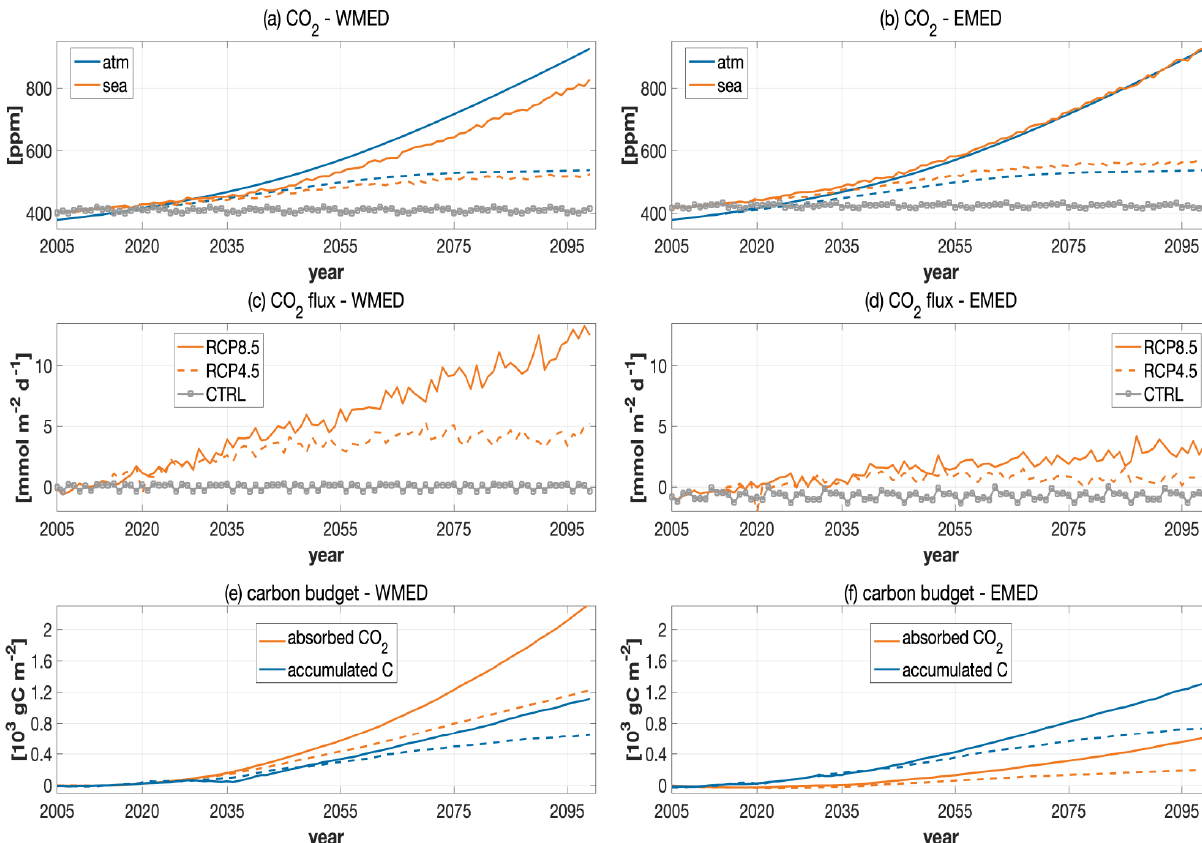
Figure 16. Time series of atmospheric and marine p CO 2 (a, b) , CO 2 air–sea exchange (c, d) and cumulative CO 2 absorbed and accumulated in the water column (e, f) in the Western (a, c, e) and Eastern (b, d, f) Mediterranean Sea. Two scenarios – RCP4.5 (dashed lines) and RCP8.5 (solid lines) – and the control simulation (CTRL, gray lines) are